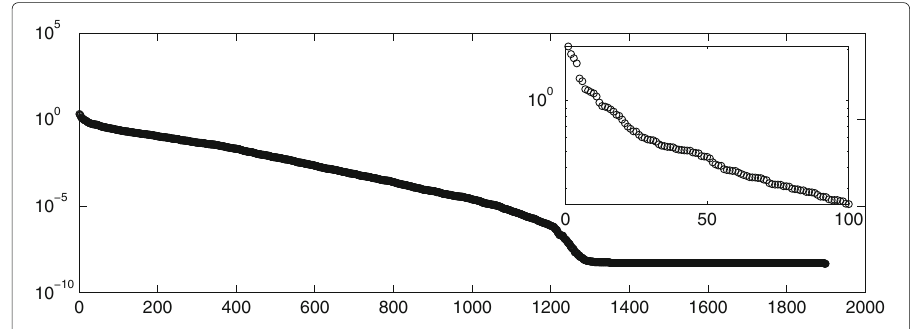
Fig. 13 Ordered broadcast vector. FBsoc: ordered broadcast vector Q [ M ] 1 ( α = 0.1). Inset: broadcast centralities of the top 100 nodes in the